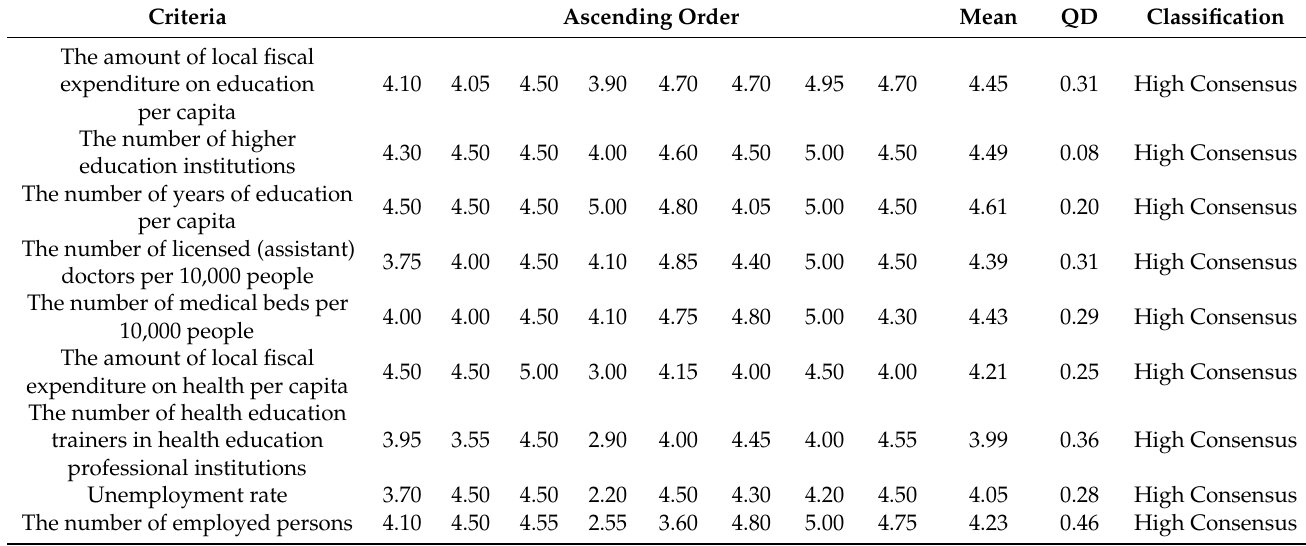
Table 5. The results of the third round of the Delphi